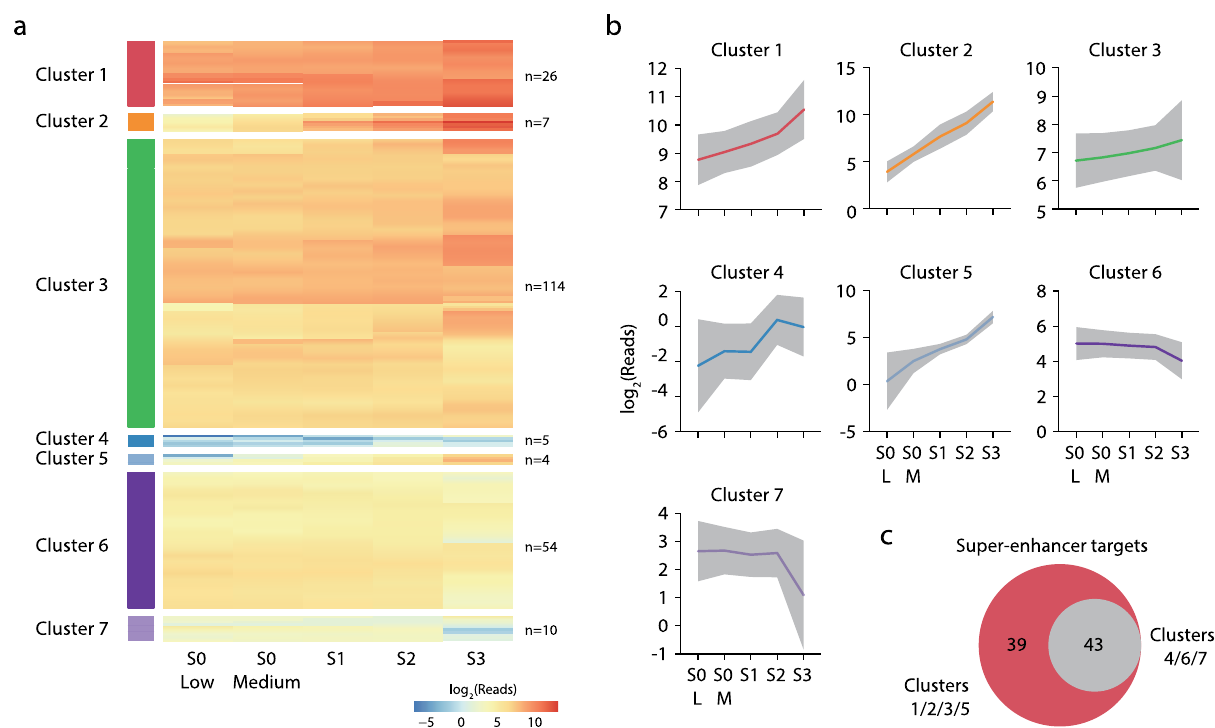
Fig. 8 Temporal expression pro fi les of super-enhancer-interacting genes. a Heirachical clustering of nascent 4sU RNA-seq in haematopoietic stem and progenitor and burst-forming unit-erythroid cells (S0-Low), early and late colony-forming unit-erythroid cells (S0-medium and S1, respectively), and maturing terminal differentiating cells (S2, S3). b Mean expression of genes in each cluster, gray shading denotes one standard deviation. c Number of super-enhancers that interact with increasing expression clusters (1,2,3,5) or low expression and stable/decreasing clusters (4,6,7). Source data are available in the Source Data fi